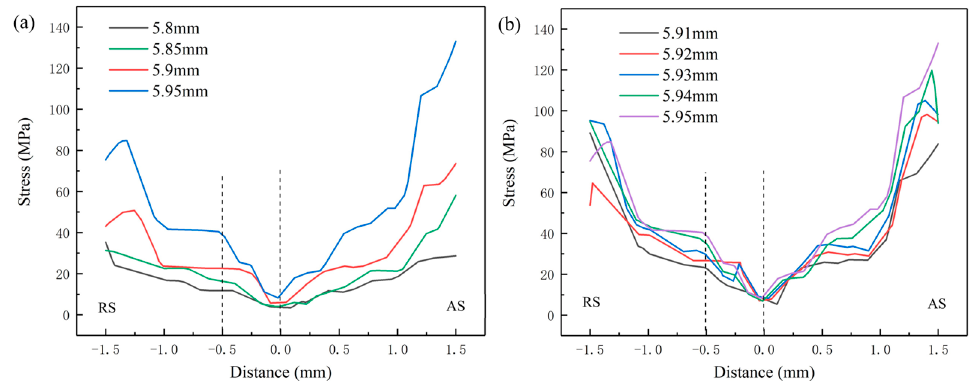
Figure 17. Distribution curves of shear stress at the root of joint with different pin lengths (1000 rpm, 120 mm / min). ( a ) 0.05 mm per step from 5.8 to 5.95 mm; ( b ) 0.01 mm per step from 5.91 to 5.95 mm.